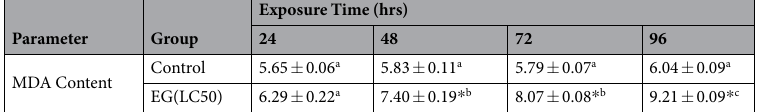
Table 5. MDA content in haemolymph of S. litura after treatment with ethyl acetate extract of S. commune . EG = Exposed group. The values represented as mean ± standard error. * Ascribes the significant difference between exposed group and control group (t-test, p ≤ 0.05). Different letters a, b, c between the columns are significantly different (Tukey’s test, p ≤ 0.05) and signify the effect of duration.